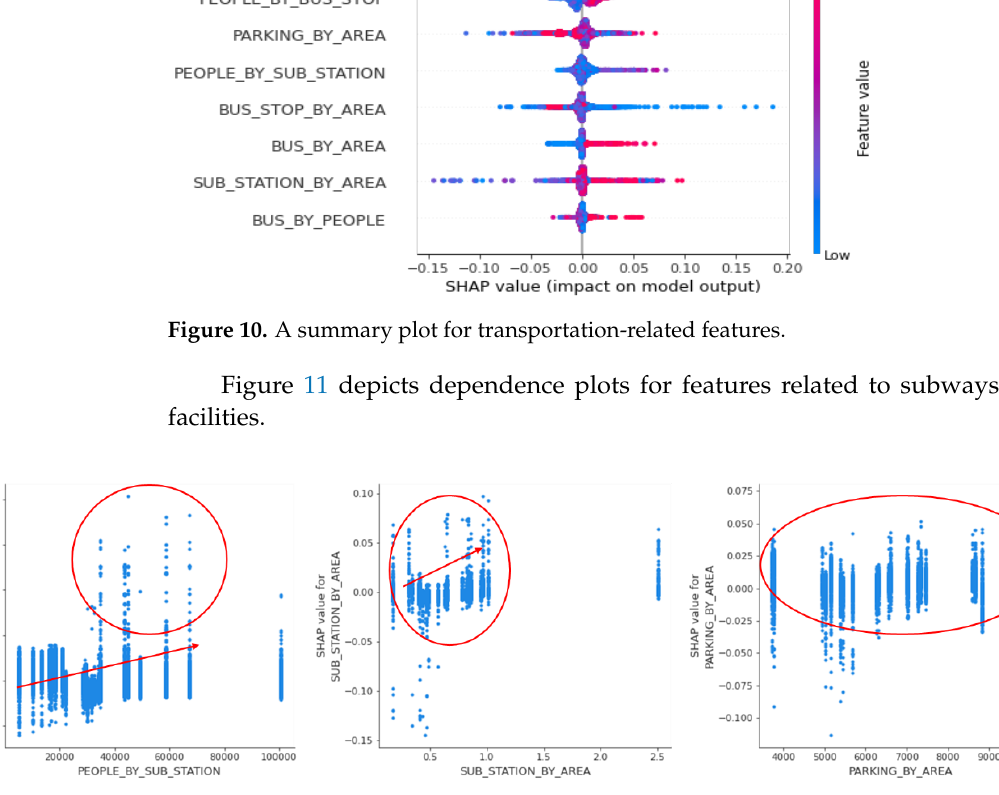
Figure 9. Transportation-related features in order by mean absolute SHAP values.